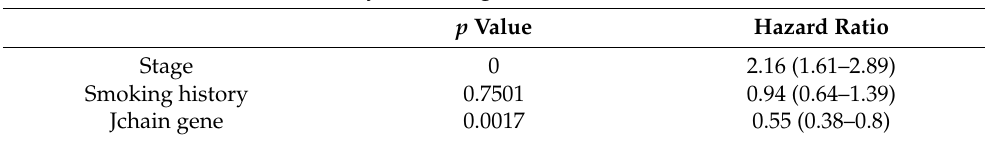
Table 6. Multivariate analysis considering first progression in adenocarcinoma patients. Multivariate analysis of J chain gene expression and smoking history and stage on time to first progression in lung adenocarcinoma (n = 384)